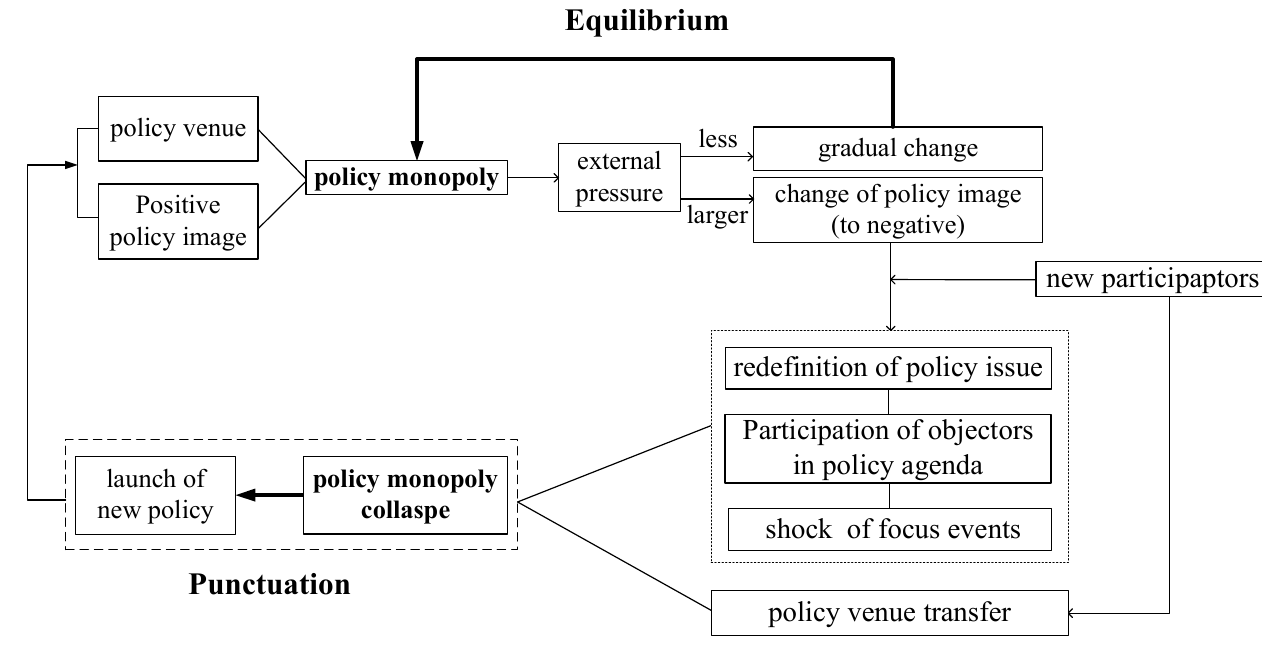
Figure 1. The theoretical framework of punctuated-equilibrium theory. Source: The figure was drawn by the authors based on the conceptual framework of our own study and other relevant literature [19,24,25] on punctuated-equilibrium theory.